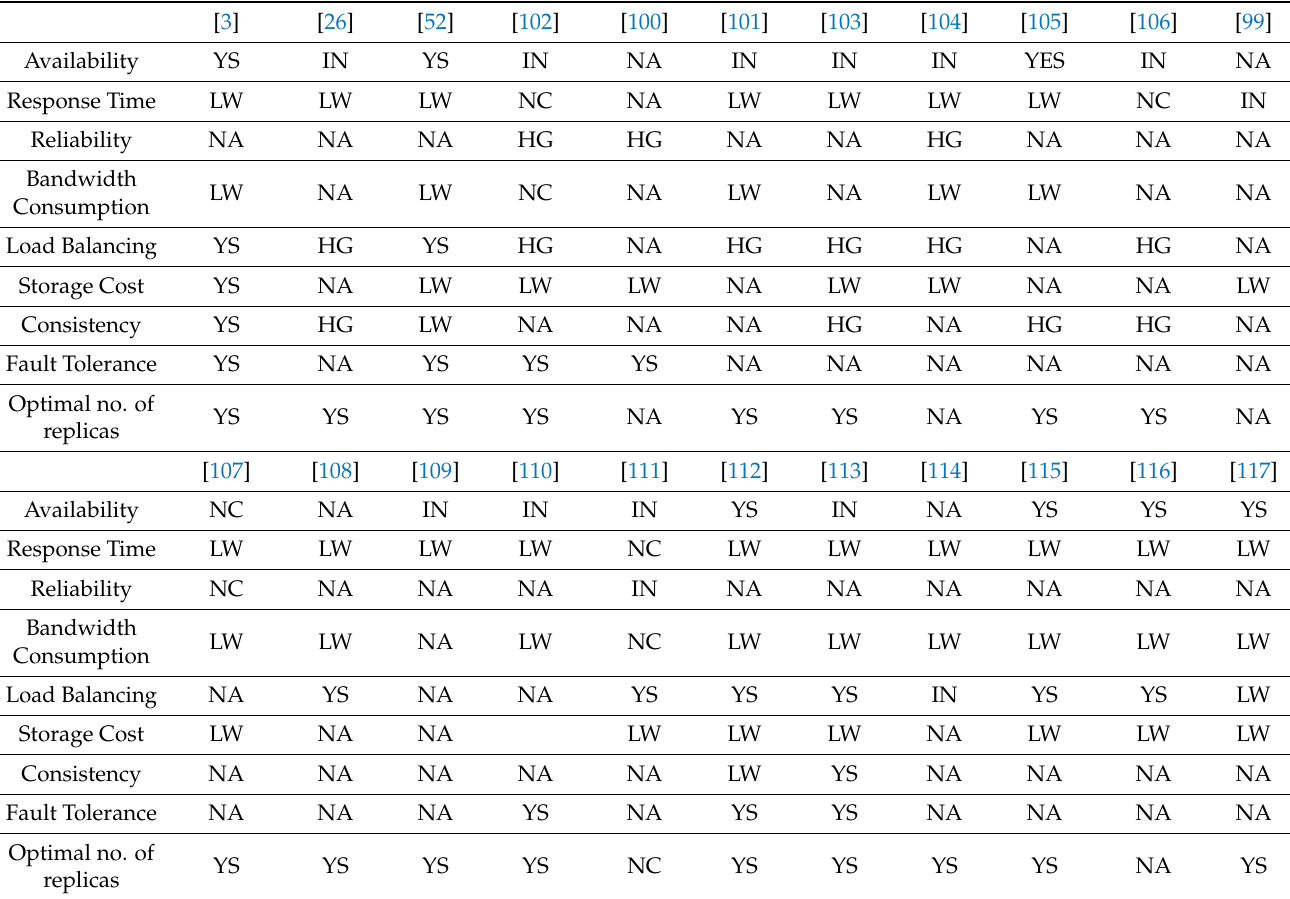
Table 7. Features of target objectives for target-oriented replication strategies in